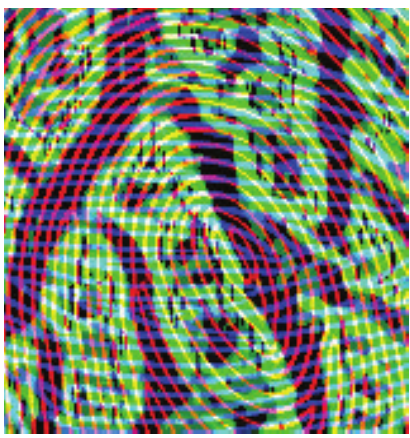
Figure 4: The original feature object set of a finger.